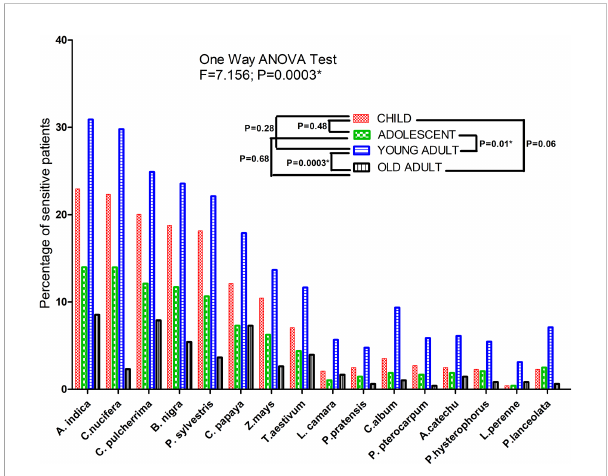
FIGURE 2 SPT sensitization pro fi le of bronchial asthma patients against different pollen allergen sources. Each bar represents percentage of sensitive patients which is divided according to three age groups. One Way ANOVA revealed a signi fi cant difference of SPT sensitivity among different age groups. For pairwise comparison, Post hoc Tukey ’ s Multiple Comparison test applied which showed signi fi cant difference of sensitivity between adolescent and adult. (*P value signi fi